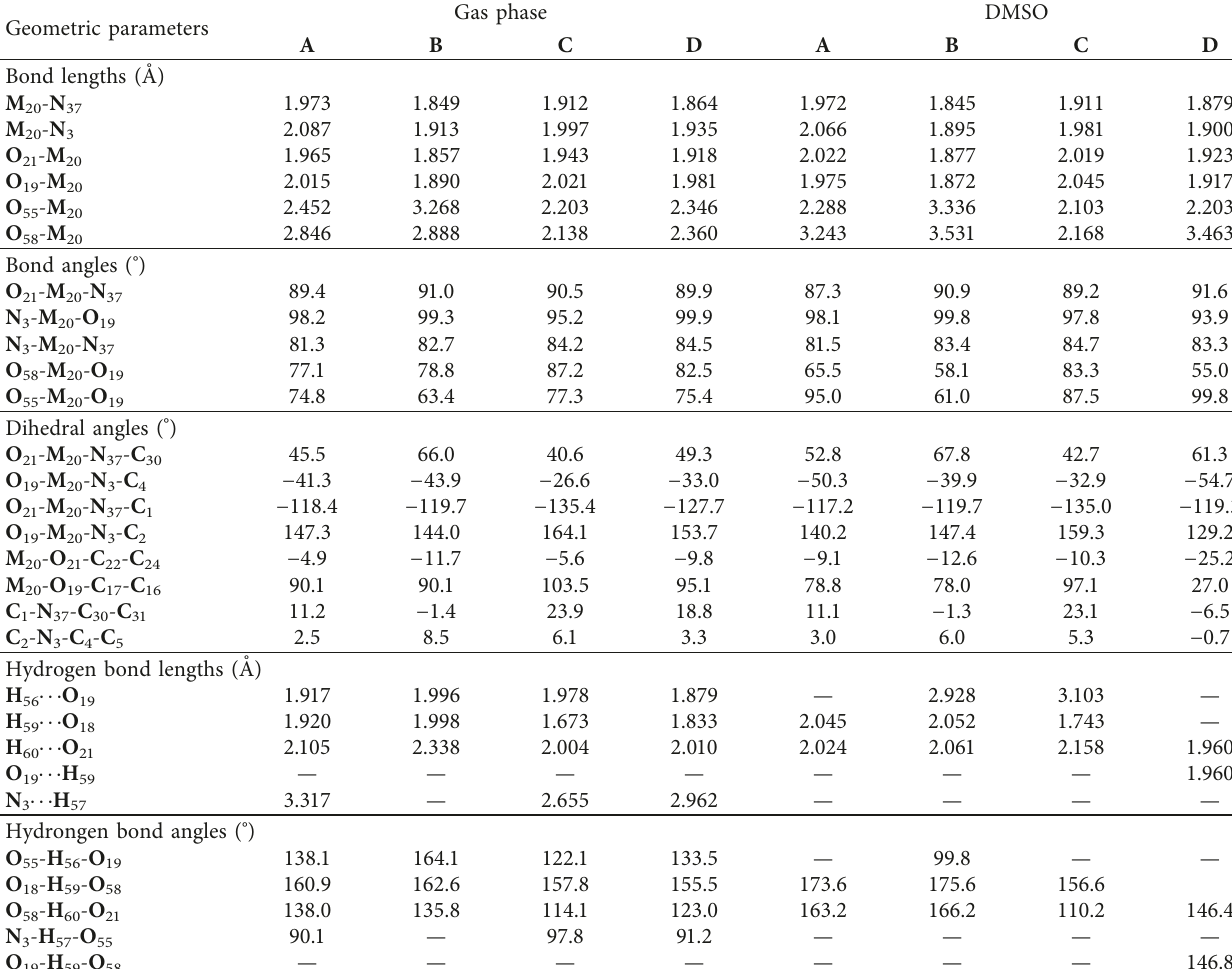
Table 1: Selected optimized geometric parameters of the complexes investigated in gas phase and